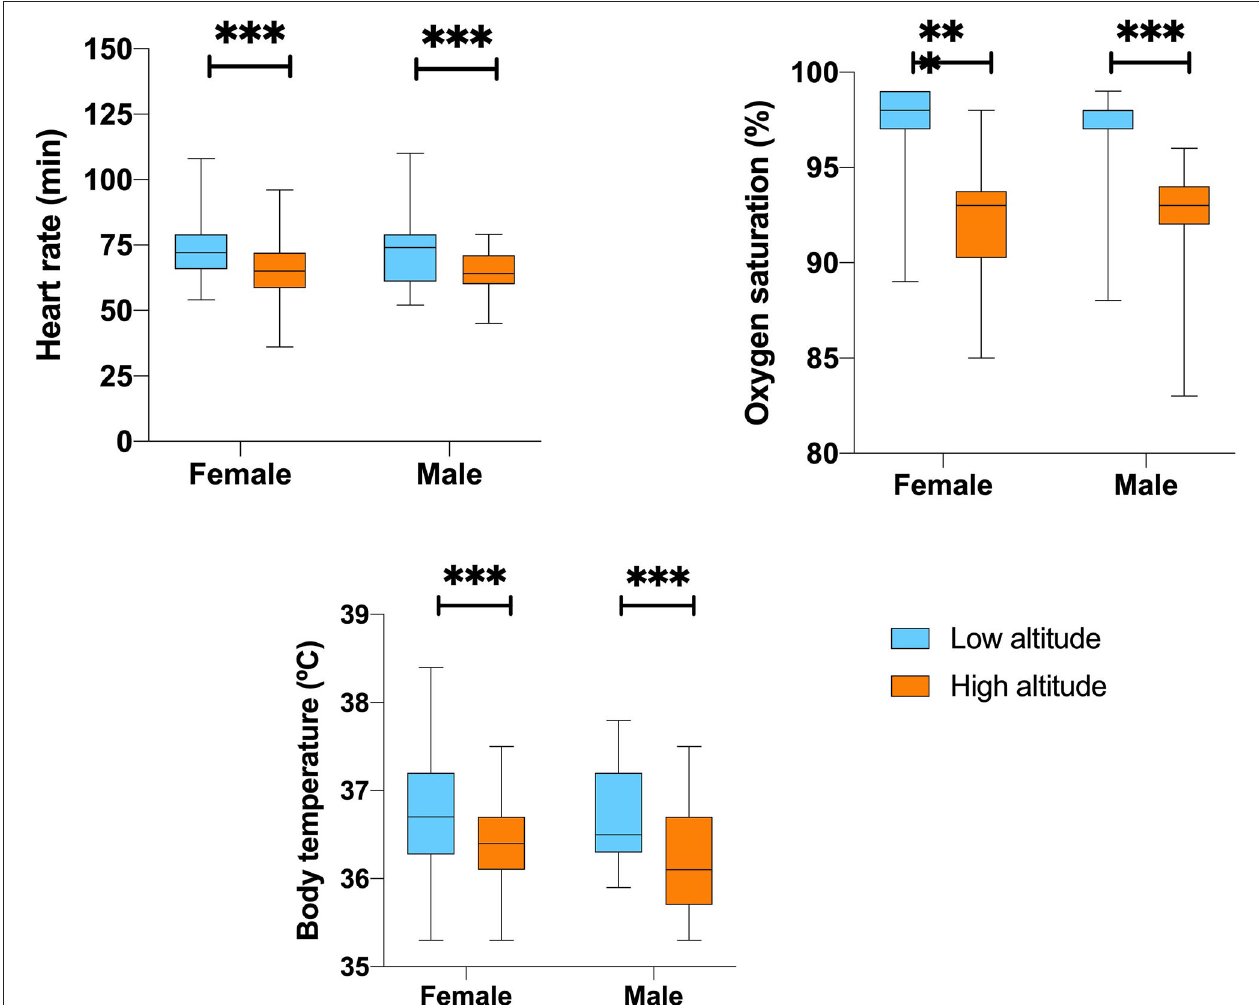
FIGURE 2 | The differences of Hematological parameter according to sex by altitude. ** , ***Represents outliers